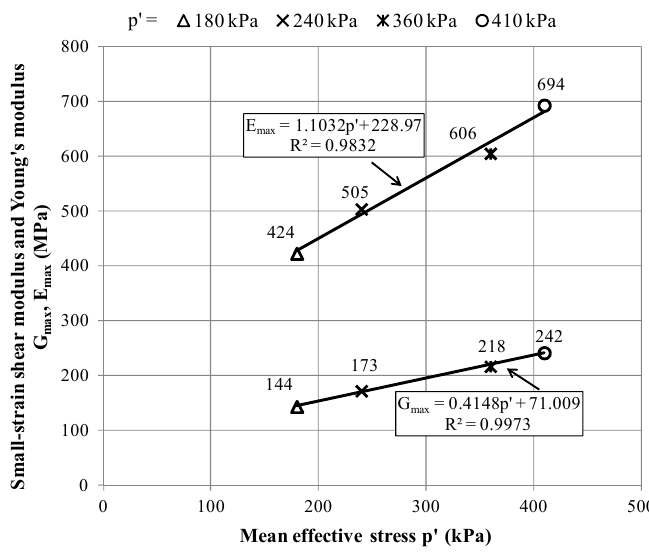
Figure 15. Elastic moduli from the start-to-start method under different stress levels.